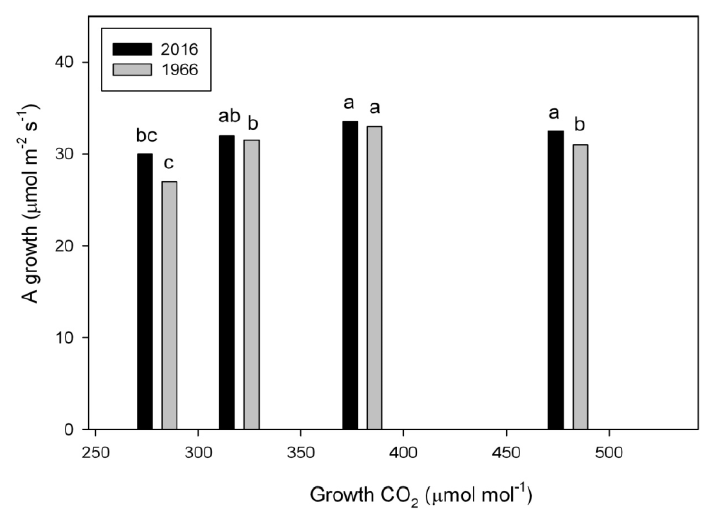
Figure 4. Carboxylation efficiency (CE) and assimilation rate (A) under the growth conditions in Datura stramonium grown at four CO 2 concentrations from seeds collected in 1966 and 2006. Different letters indicate significant differences, based on analysis of variance.